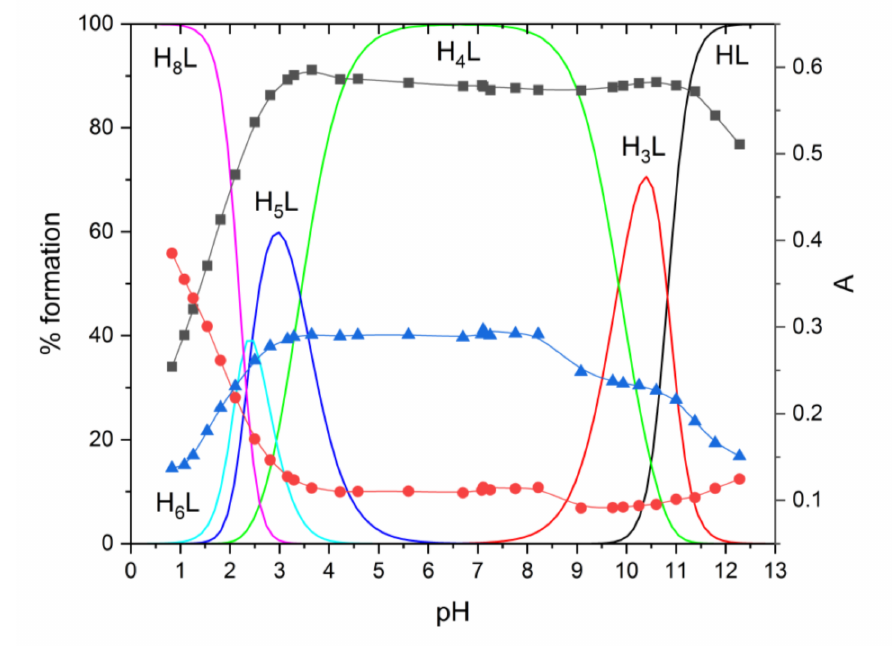
Figure 3. pH dependence of 328 (black), 271 (red), and 230 (blue) nm absorption bands superimposed to species distribution diagram ([H 3 L] = 1.2 × 10 − 5 M). Charges omitted for